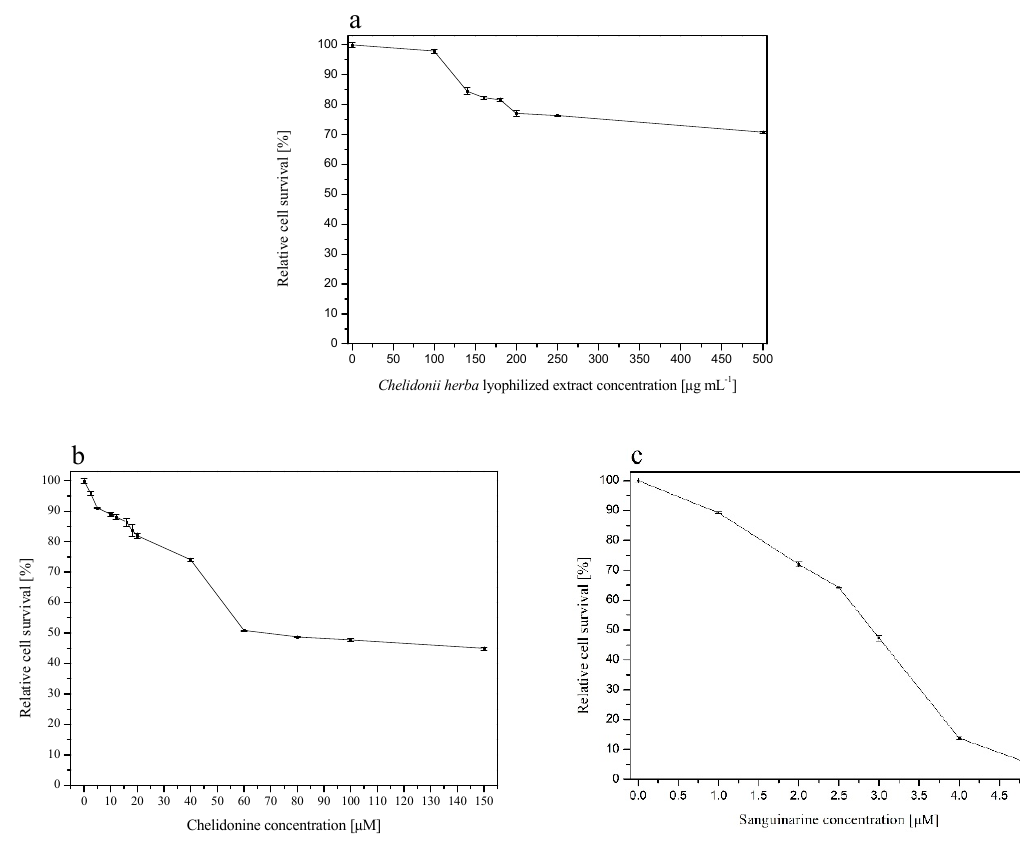
Figure 2. Cytotoxic e ff ect of Chelidonii herba lyophilized extract ( a ), chelidonine ( b ), and sanguinarine ( c ) on MCF10A cells.